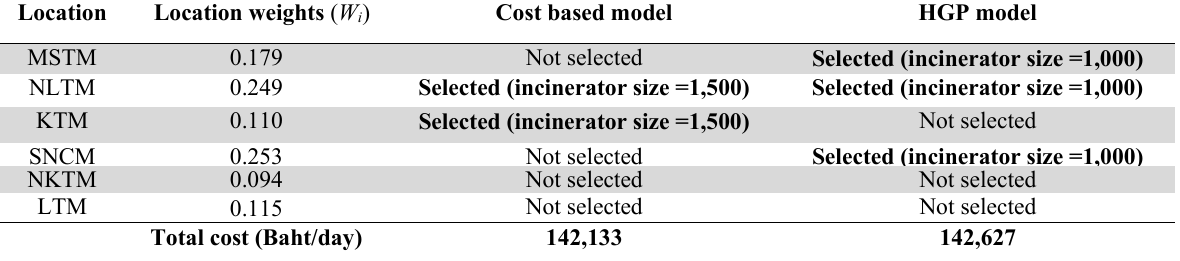
Comparison of Cost based model and HGP model